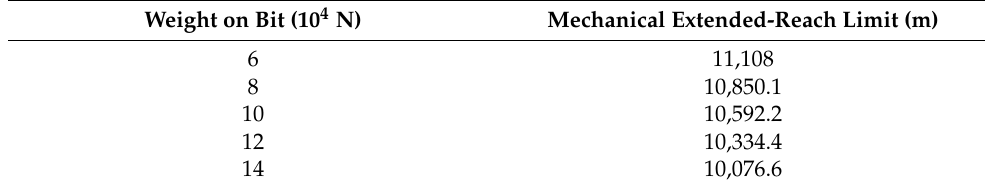
Table 9. Mechanical extended-reach limits with different weights on bit.